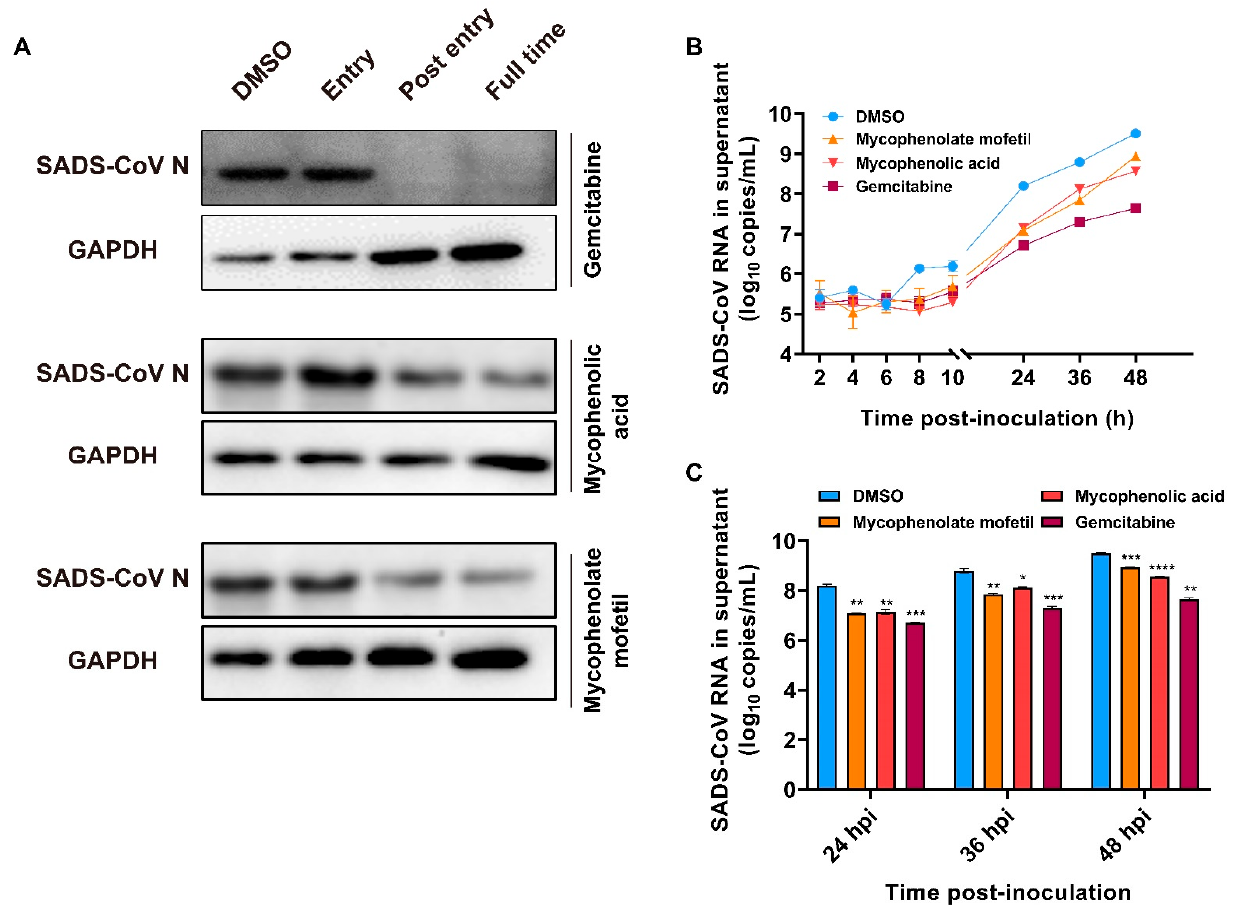
Figure 7. Gemcitabine, mycophenolate mofetil, and mycophenolic acid can inhibit SADS-CoV replication. ( A ) The expressions of viral proteins in cells after 48 h SADS-CoV infection with different treatments. ( B ) The growth kinetics of SADS-CoV in the presence of gemcitabine (6.25 μ M), mycophenolate mofetil (12.5 μ M), and mycophenolic acid (12.5 μ M), respectively. ( C ) The expression of SADS-CoV RNA in the supernatant at 24 hpi, 36 hpi, and 48 hpi in the presence of indicated compounds. DMSO was added as the positive control. The experiments were repeated at least twice. Error bars represent ±1 SD, * p < 0.05, ** p < 0.01, *** p < 0.001, **** p < 0.0001 by Student’s t -test.